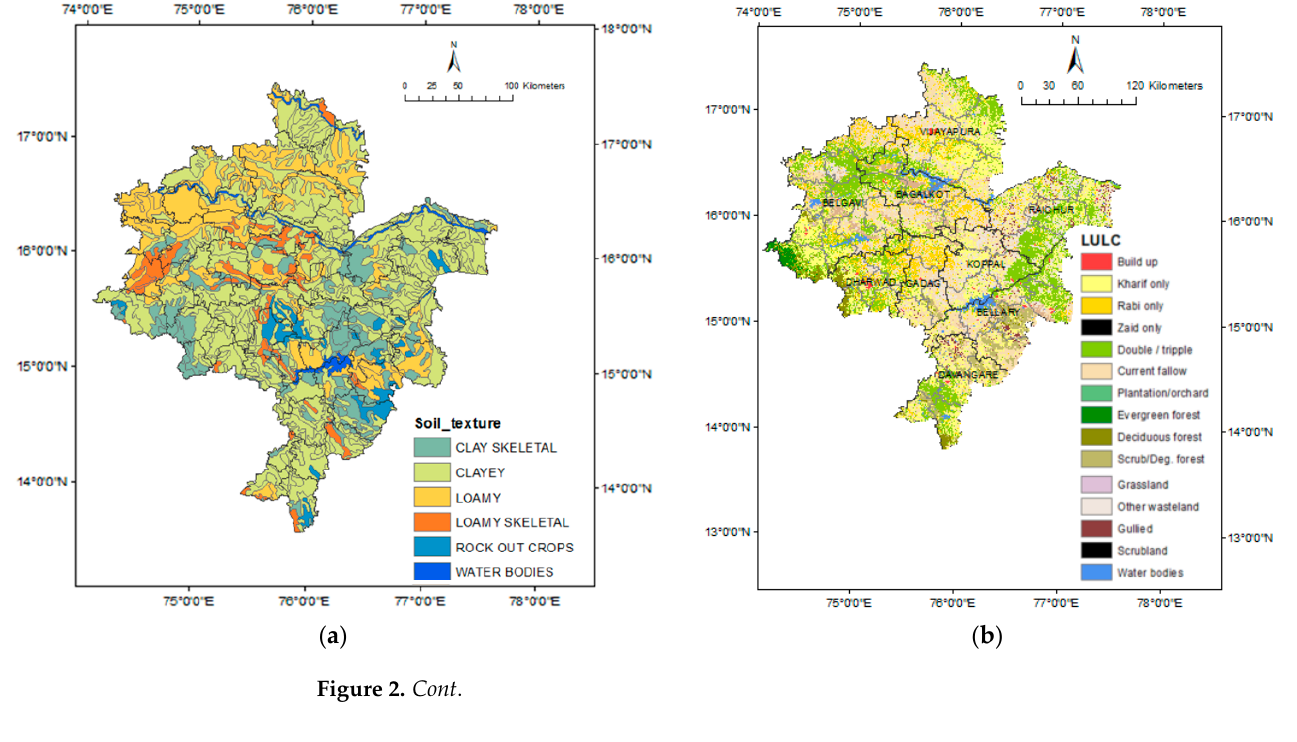
Figure 1. ( a –c) Location map and gauging stations of northern dry zone of Karnataka in Krishna basin of India.